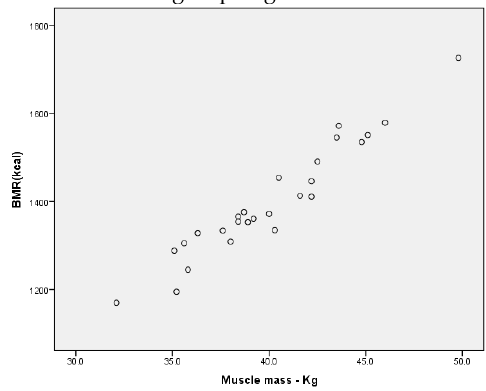
Graph 4. Correlation between BMI and muscle mass % for the group of girls with MID